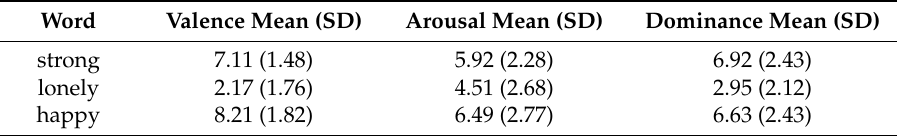
Table 2. Sample annotations of words from ANEW